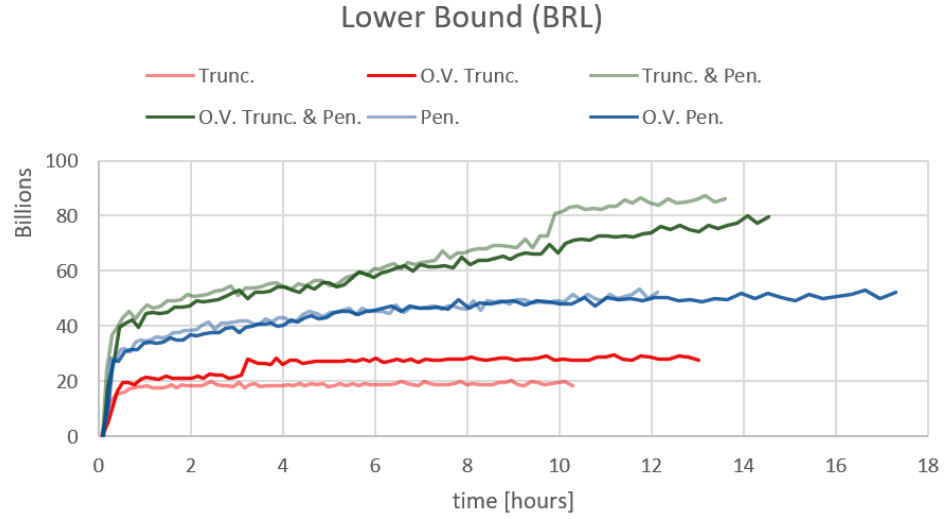
Figure 13. Optimization process-Lower bound evolution per time.